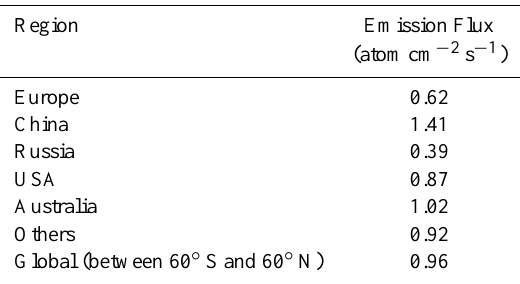
Table 1. Regionally averaged annual mean radon emission flux over land in the merged radon flux